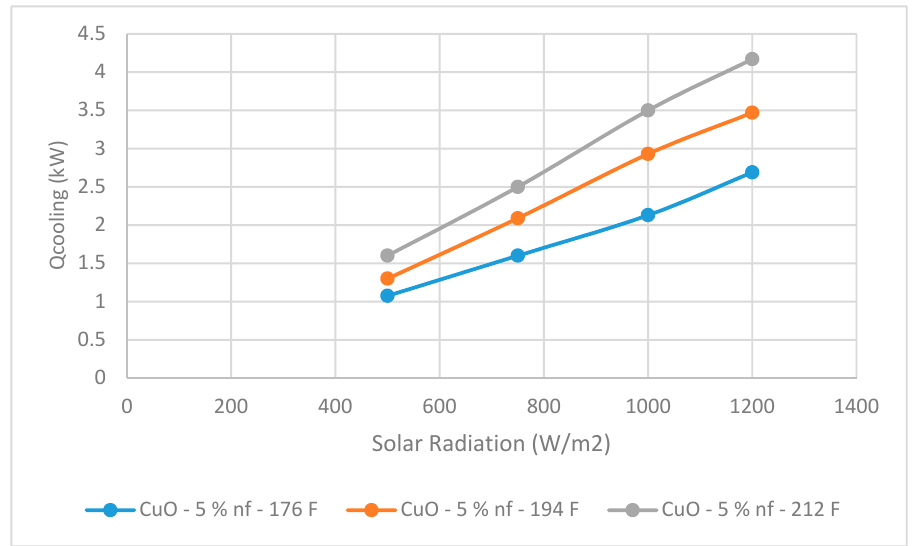
ff ect for CuO at 5% Figure 15. Cooling load effect for CuO at 5% concentration. Figure 15. Cooling load e Figure 15. Cooling load effect for CuO at 5% concentration.